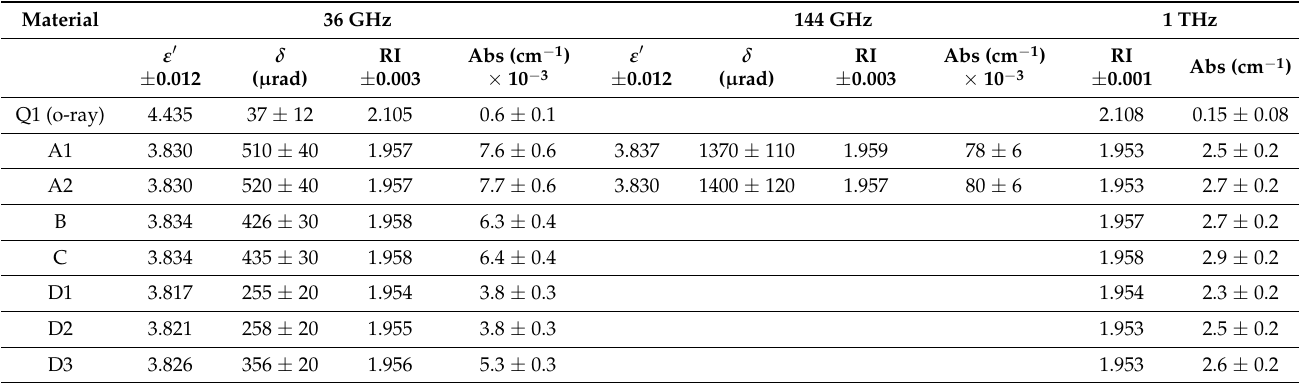
Figure 8. Absorption coefficients of Spectrosil 2000 silica glass samples. Table 1. Permittivity, loss, refractive index, and absorption coefficient of quartz and silica samples were measured using the open resonator at 36 GHz and 144 GHz, and using time-domain spectroscopy at 1